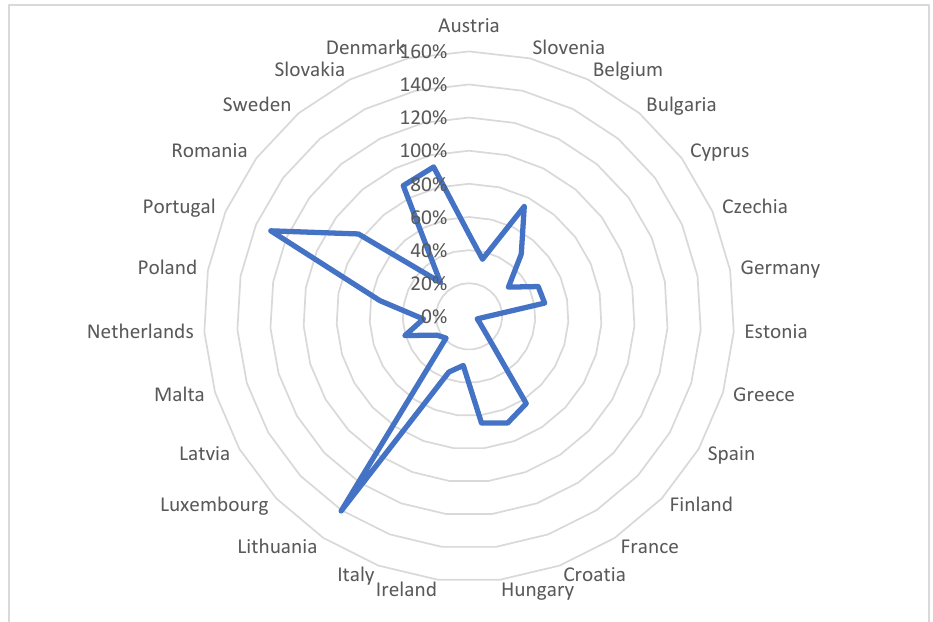
Figure 6. Disparities in policies to combat heavy metal water pollution in the EU.